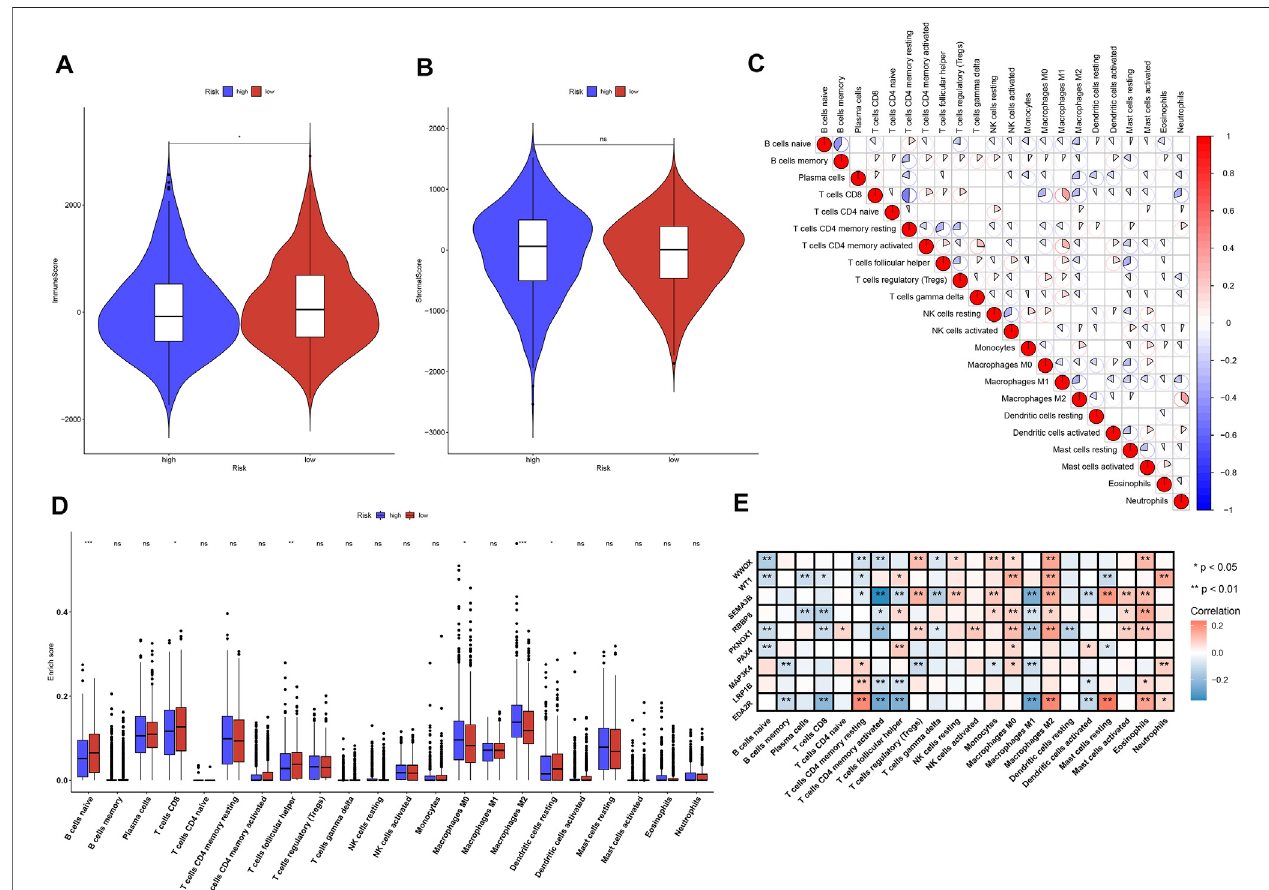
FIGURE 6 | Association between the TSG-based prognostic classi fi er and tumor-in fi ltrating immune cells across breast cancer in TCGA dataset. (A,B) Comparisons of the immune score and stromal score between high- and low-risk subgroups. (C) Spearman ’ s correlation between the in fi ltration levels of 22 immune cells in breast cancer specimens. Red, positive correlation; blue, negative correlation. (D) Comparisons of the in fi ltration levels of 22 immune cells between high- and low-risk subgroups. (E) Spearman ’ s correlation between the mRNA expression of characteristic TSGs in the prognostic classi fi er and the in fi ltration levels of 22 immune cells across breast cancer specimens. Red, positive correlation; blue, negative correlation. Ns: not signi fi cant; * p -value < 0.05; ** p -value < 0.01 and *** p -value <